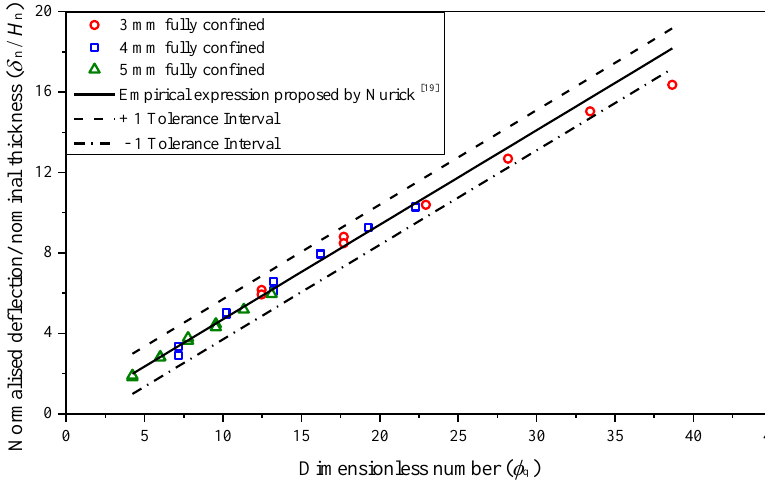
Figure 3. The normalized deflection–nominal thickness ratio ( δ n / H n ) versus the dimensionless number ( φ q ) for Geretto’s confined blast tests.